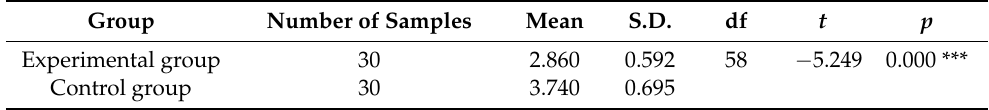
Table 5. Results of t -test on cognitive load for both groups. Group